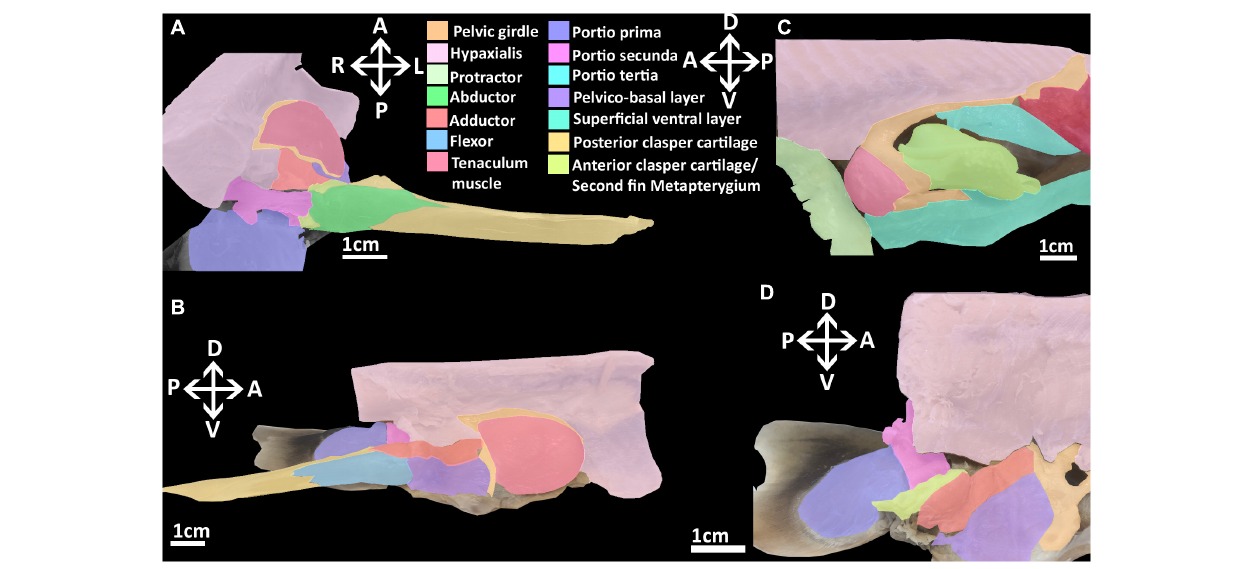
FIGURE 3 | Dissection of the musculature of the pelvic fin and clasper cartilages of the elephant shark ( Callorhinchus milii ). (A) Posterior view of a dissected male elephant shark, with the pelvic clasper drawn out proximally, (B) medial view of a bisected male elephant shark, showing the internal reproductive musculature, (C) lateral view of a male elephant shark with the protractor and abdominal adductor muscles removed, (D) medial view of a dissected female elephant shark showing the musculature associated with the second fin metapterygium. Anatomical planes and position indicated by lettering: A, Anterior; P, Posterior; D, Dorsal; V, Ventral; R, Right, L,